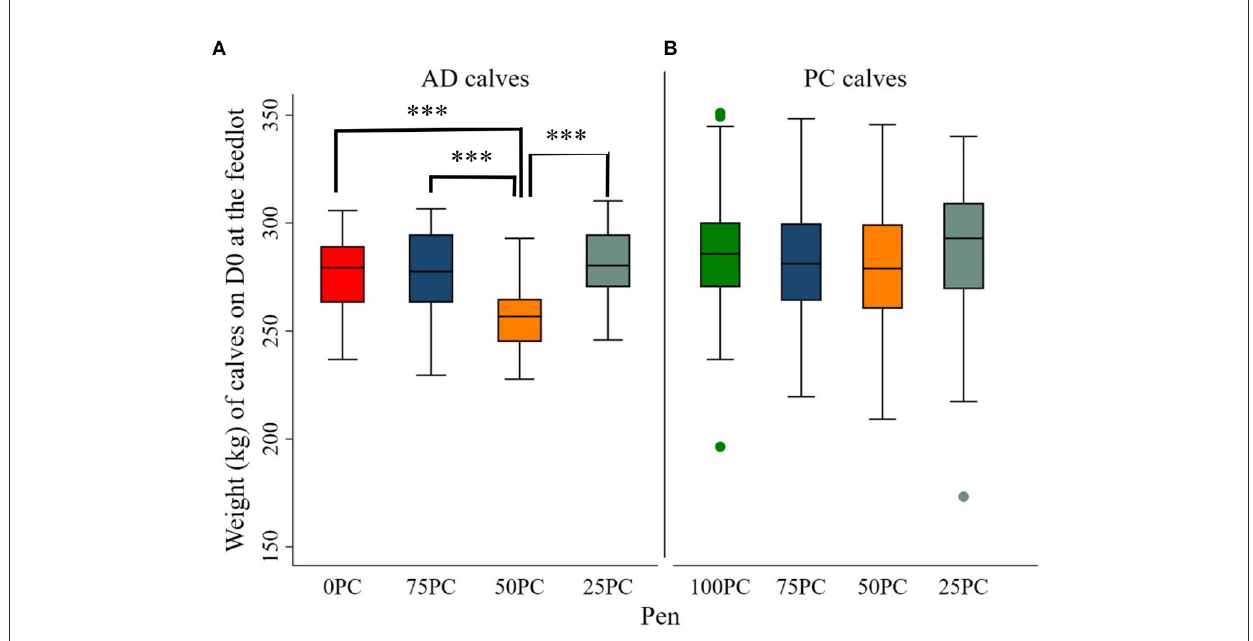
FIGURE5 Body weight of calves on D0 at the feedlot. (A) Represents auction-derived (AD) calves in each pen. (B) Represents preconditioned (PC) calves in each pen. ab Counts without a common superscript differed ( P < 0.0001).